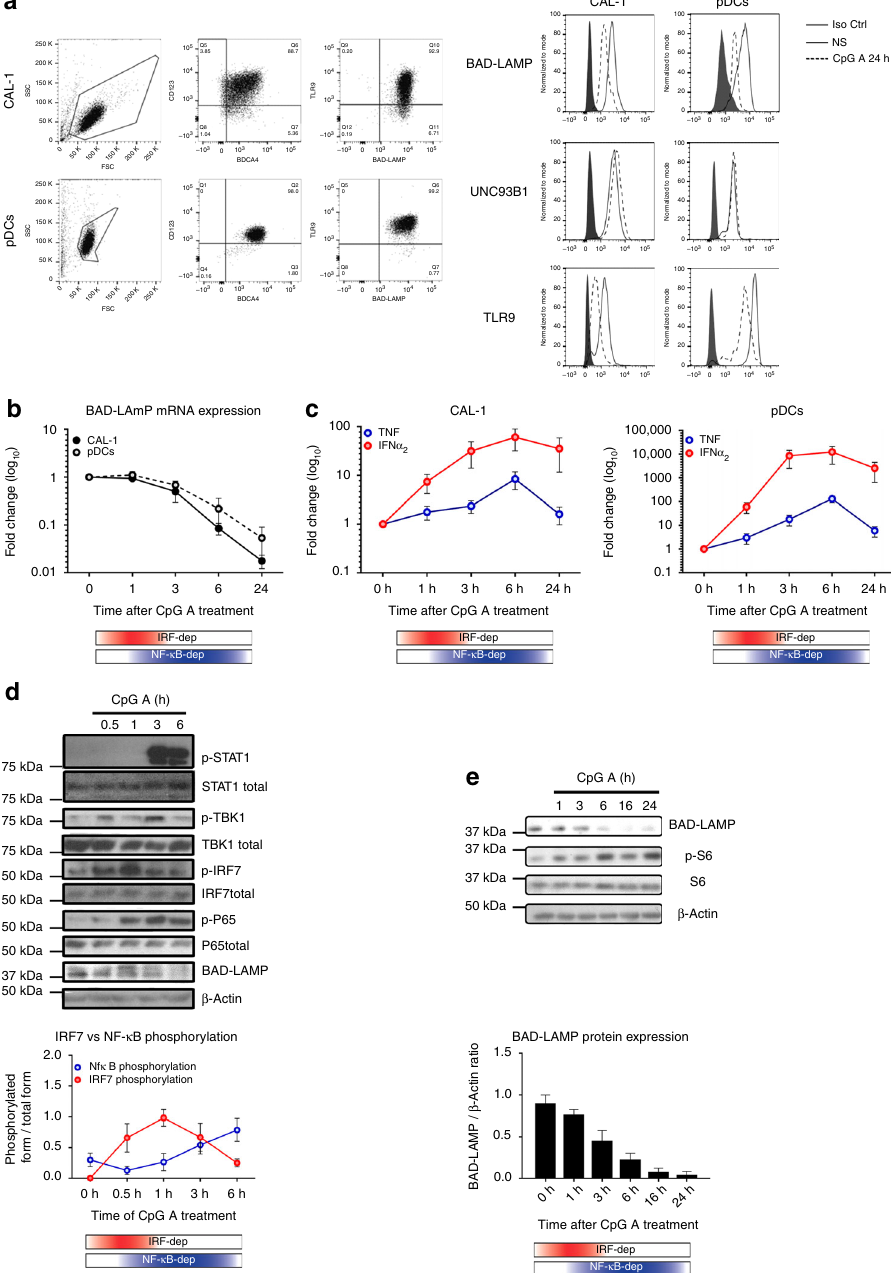
Fig. 1 BAD-LAMP is down-modulated after IRF7 activation. a ( left ) Flow cytometry analysis of CAL-1 cells ( top ) and freshly isolated pDCs ( bottom ) from healthy donors stained for both extracellular (CD123 and BADCA4) and intracellular (TLR9 and BAD-LAMP) pDCs markers. ( right ) Flow cytometry histogram plots of intracellular staining for BAD-LAMP, TLR9 and UNC93B1 in both CAL-1 ( left ) and freshly isolated pDCs ( right ) at steady state ( black line ) and after 24 h of CpG-A stimulation ( dashed line ). Full grey histograms represent isotype controls staining. Data are representative of a minimum of three independent experiments. b CAL-1 ( black line ) and freshly isolated pDCs ( dashed line ) were treated with CpG-A for indicated times. BAD-LAMP mRNA levels were measured by RT-qPCR. Raw data have been normalised to housekeeping gene (GAPDH) and graphics represent fold change ± s.d. compared to non-stimulated cells from a minimum of three independent experiments. c IFN α 2 ( red ) and TNF ( blue ) mRNA level from CAL-1 ( left ) and freshly isolated pDCs ( right ) were measured by RT-qPCR. Raw data have been normalised to housekeeping gene (GAPDH) and graphics represent fold change ± s.d. compared to non-stimulated cells from a minimum of three independent experiments. d ( top ) CAL-1 cells were treated with CpG-A for indicated times prior lysis and sodium dodecyl sulphate – polyacrylamide gel electrophoresis treatment. Expression of BAD-LAMP, TBK1, IRF7, STAT1, the p65 NF- κ B subunit, Ribosomal S6 and their phosphorylated forms were detected by immunoblot. β -actin is shown as loading control. d ( bottom ) Quanti fi cation of IRF7 ( red ) and p65 ( blue ) phosphorylation levels. Graphics represents data normalised to total form levels for each protein ± s.d. from three independent experiments. e ( bottom ) Quanti fi cation of BAD-LAMP protein expression by Image J pixel quanti fi cation. Graphics represents data normalised β -actin levels ± s.d. from three independent experiments. The bimodal regulation of TLR9 signalling is represented with a shading red rectangle for its IRF7-dependent phase and blue for its NF- κ B-dependent phase